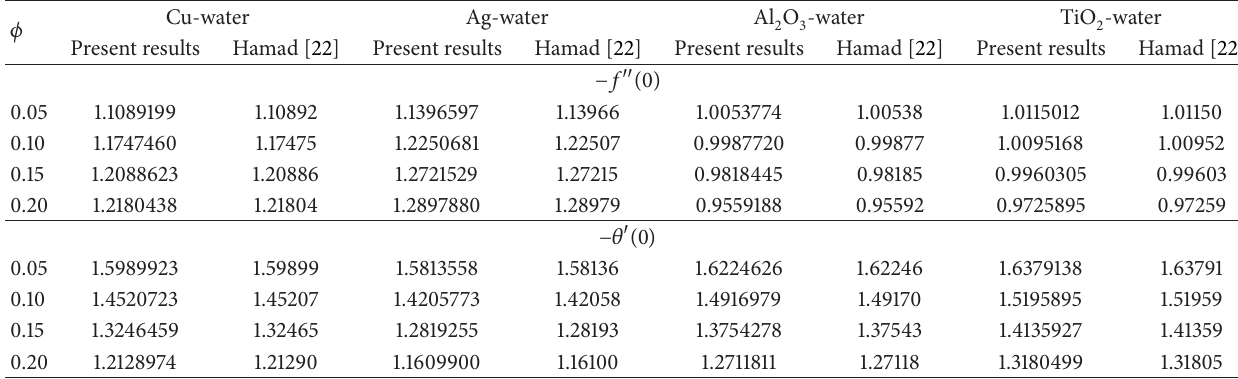
Table 3: Comparison between the results of −𝑓 󸀠󸀠 (0) and −𝜃 󸀠 (0) for different nanoparticles when Pr = 6.2 , 𝑠 = 0 , and 𝛿 1 = 𝛿 2 = 0 .